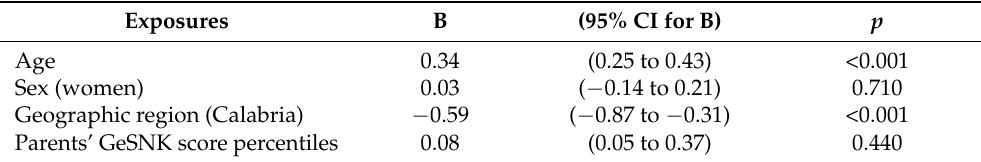
Table 5. Determinants of nutritional knowledge of students at multivariate linear regression *.